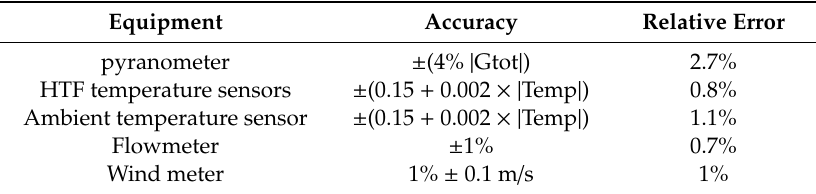
Table 2. Accuracies of the measuring